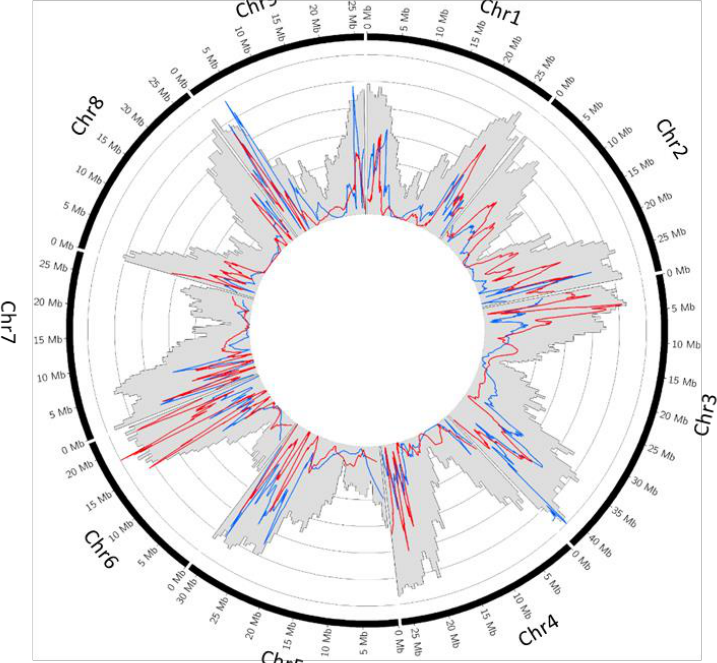
Figure 1. Circos plot of the recombination rate along the nine chromosomes. The red lines represent the recombination rate of the Swingle citrumelo and the blue lines Volkamer lemon (Min = 0; Max = 11.72 cM/Mb). The grey histogram represents the gene density in the P. trifoliata reference genome (Min = 0; Max = 0.57).